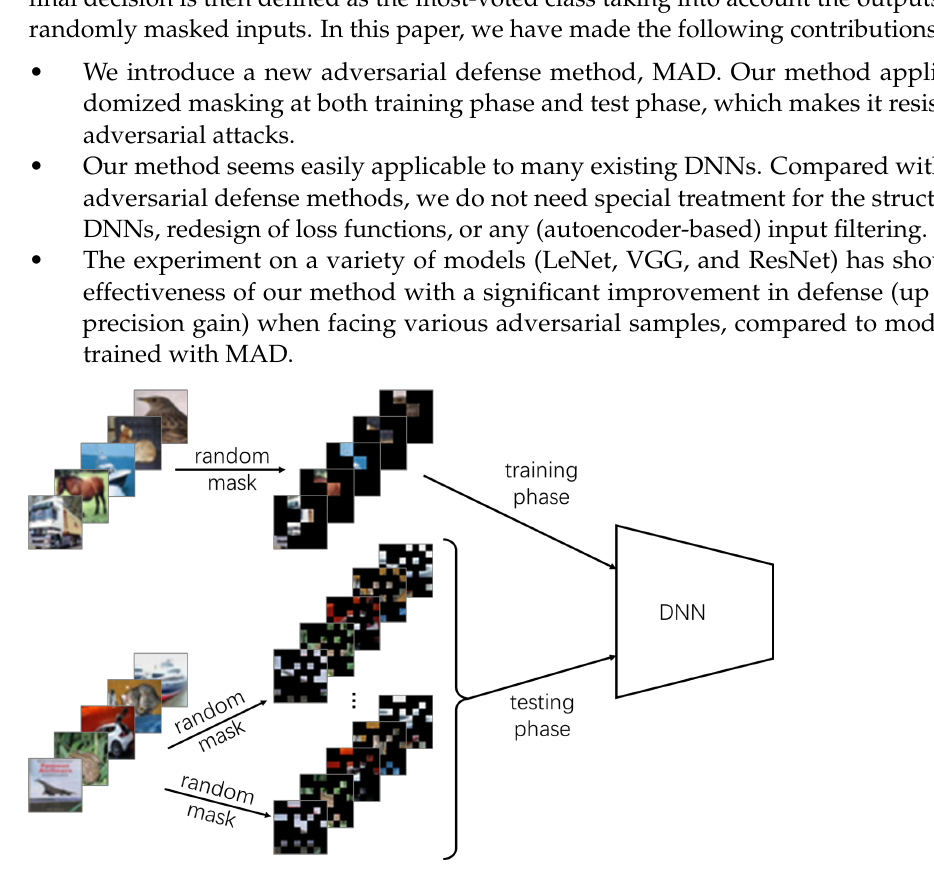
Figure 1. An overview of the MAD